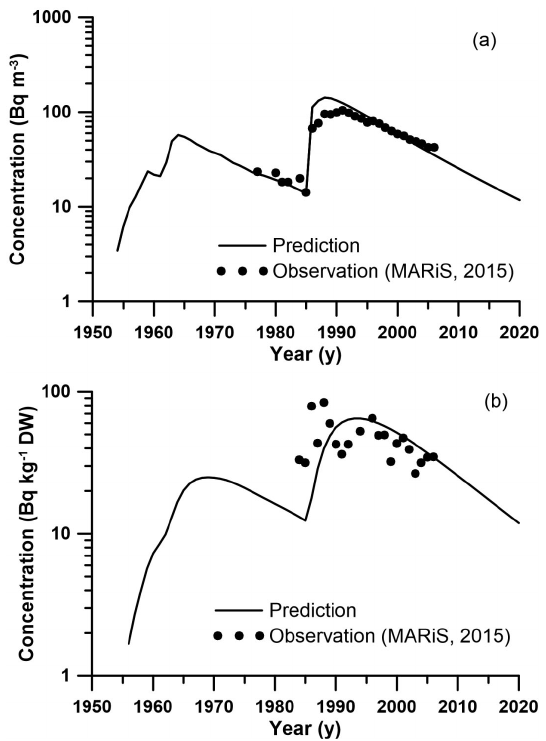
Figure 6. Comparison between calculated and observed 137 Cs con- centrations in seawater (a) and in bulk bottom sediment (b) for box number 45. Values in (b) are given in becquerels (Bq) per kilogram (kg) of dry weight